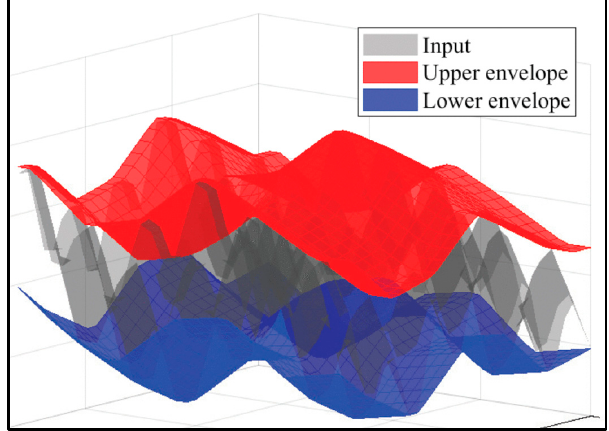
Figure 3. Illustration of the Sifting process for a 3D surface. The sifting process is carried out by iteratively estimating the Upper and Lower envelopes from the input signal, followed by computing the average envelope. Each iteration leads to an IMF, and finally, the iteration is stopped based on a fixed number of maxima or minima in the envelopes [41].